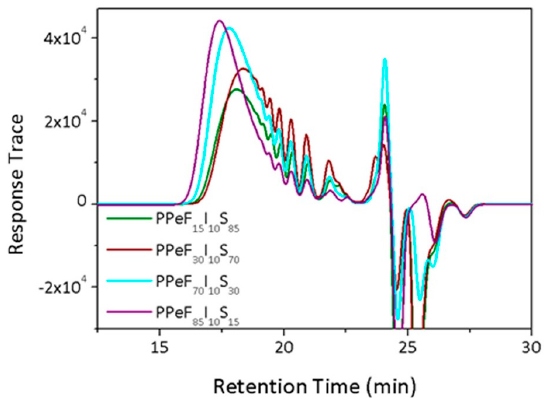
15 IS 85 and ( b ) PPeF 85 IS 15 .